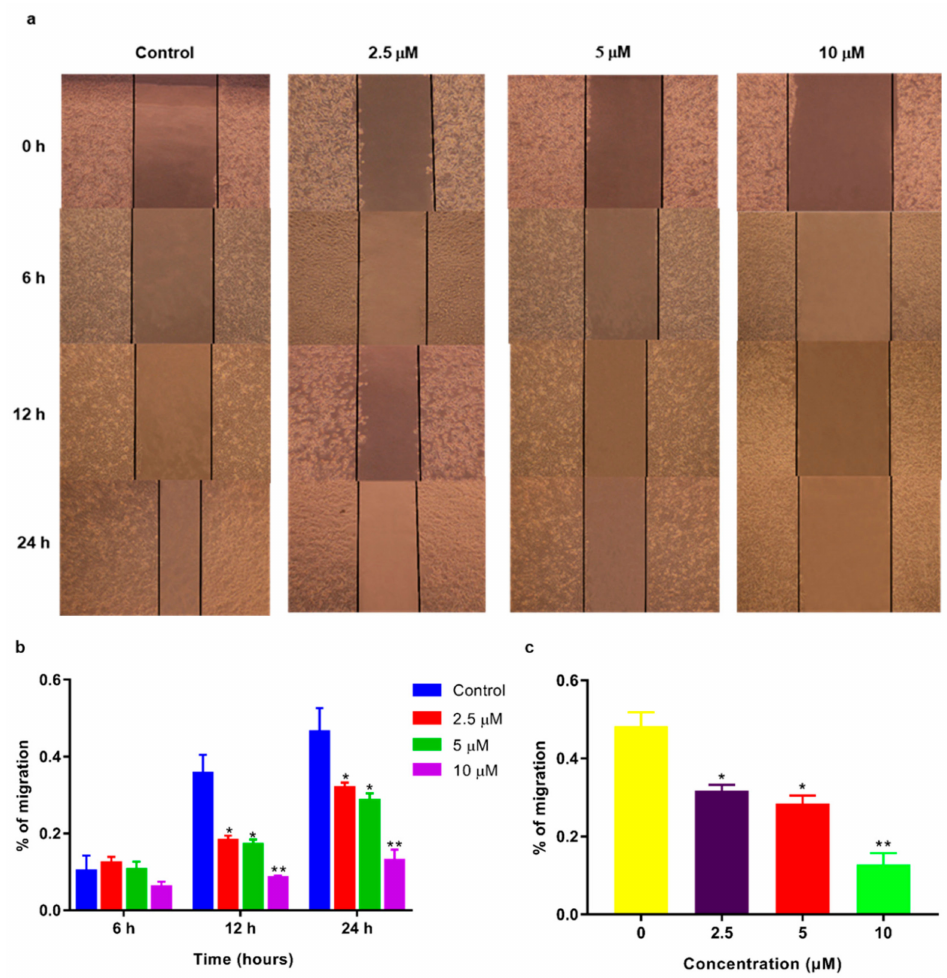
Figure 3. After treatment with TSC-3C , MDA-MB-231 cells were scratched and observed for a given time. ( a ) Images of the wounds over time in cells treated with di ff erent concentrations of TSC-3C (100 × ). ( b ) Histogram showing the migration rate at di ff erent times compared with that at 0 h. ( c ) Histogram of the MDA-MB-231 cell migration rate after 24 h. The data are expressed as the means ± SD ( n = 3). * p < 0.05 vs. the control group, ** p < 0.01 vs. the control